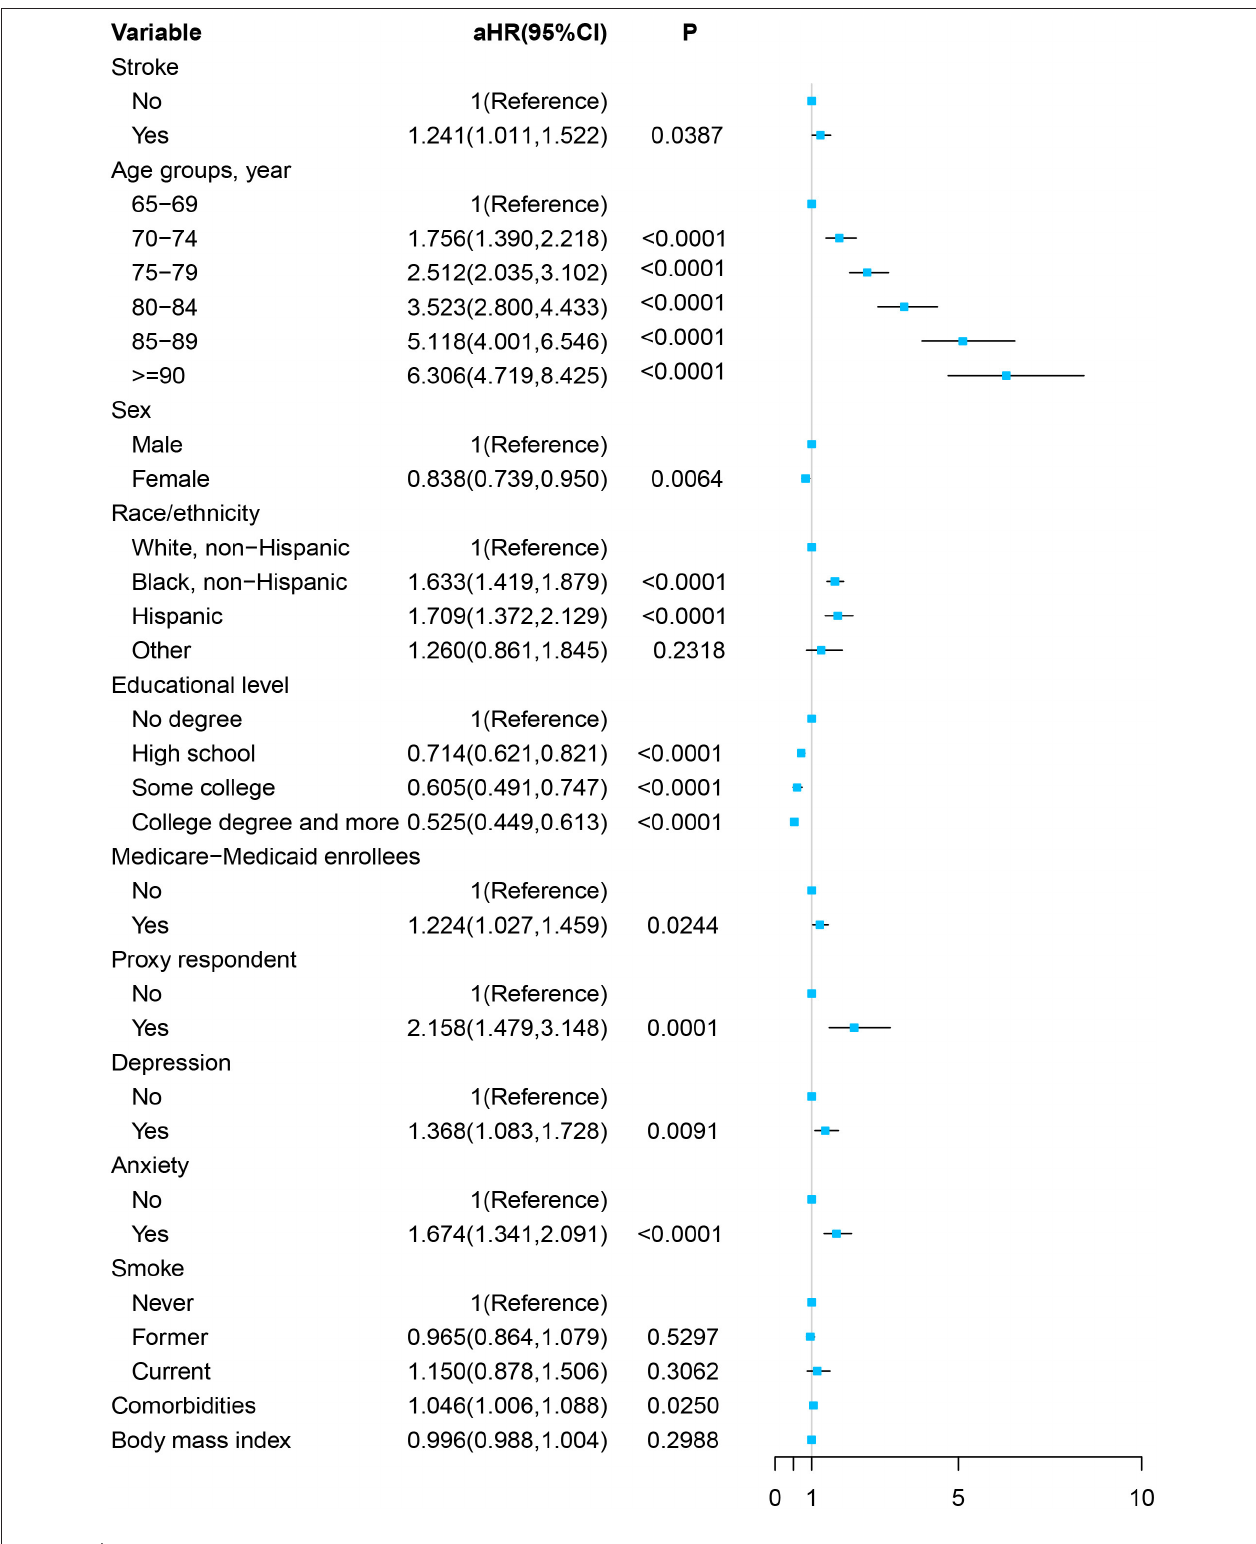
Frontiers in Public Health |